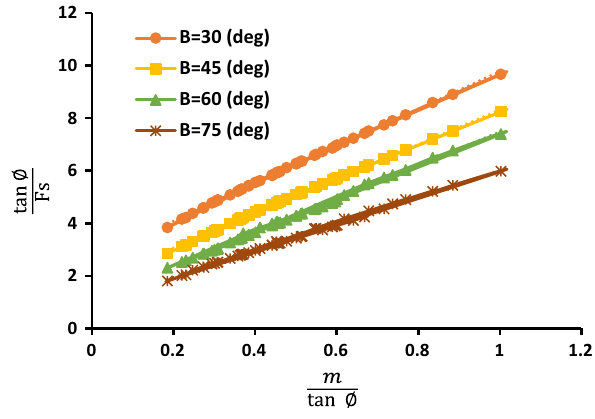
Fig. 8 Determination of the factor of safety against the stability num- ber for different angles Table 3 The regression equations extracted from the Michalowski (2002) Equation